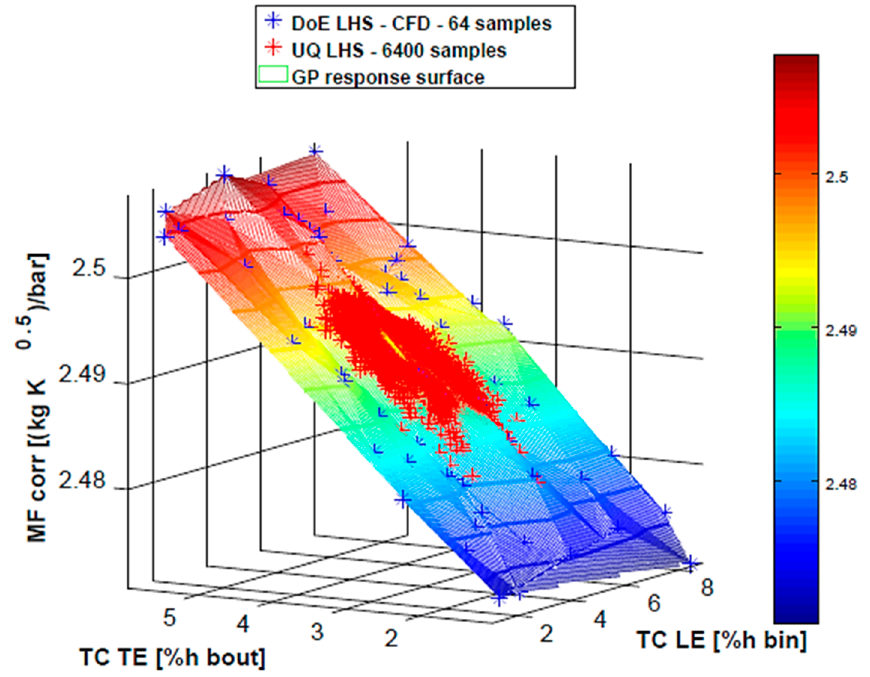
Figure 11. SB-UQ: mass flow parameter response surface and samples.